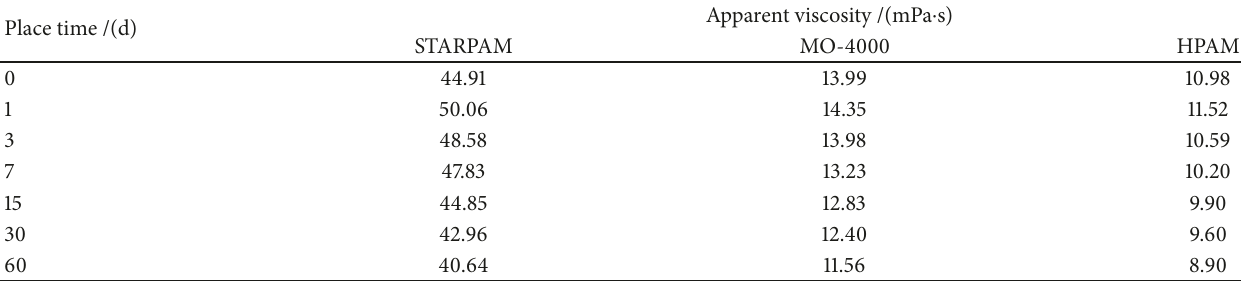
Table 6: The relationship between three kinds of polymer viscosity and aging time.